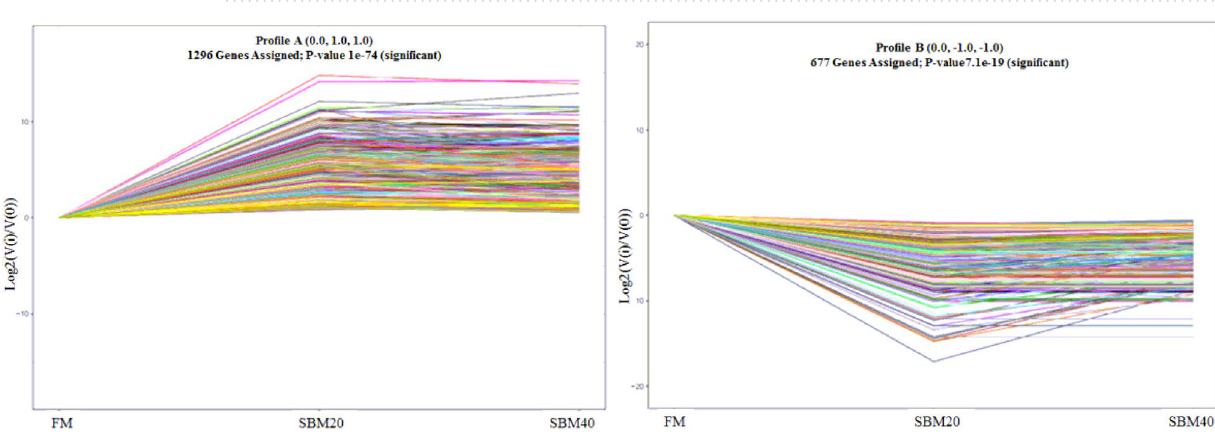
Figure 9. The transcriptome trend analysis of DEGs of (n =